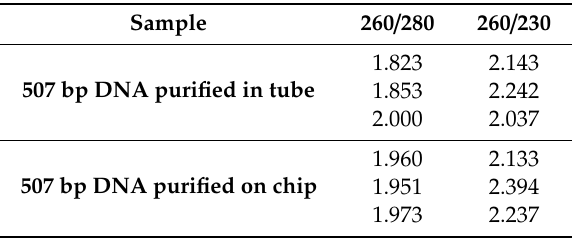
for COMSOL simulation. Figure S3. X-direction ( a – c ) and y-direction ( d – f ) magnetic force on the beads crossing the main channel with varying fluid velocities and the NdFeB magnet at different positions: (a) and (d) position 1, (b) and (e) position 2, (c) and (d) position 3. The data for the beads deflected to the wall of branched channel are selected, obtained from Comsol 5.3a. Figure S4. X-direction ( a – c ) and y-direction ( d – f ) velocities of beads crossing the